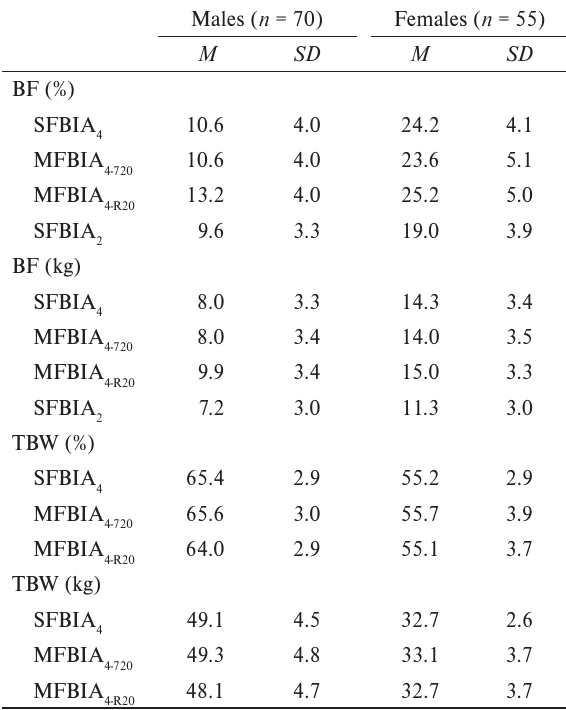
Values of the body fat and total body